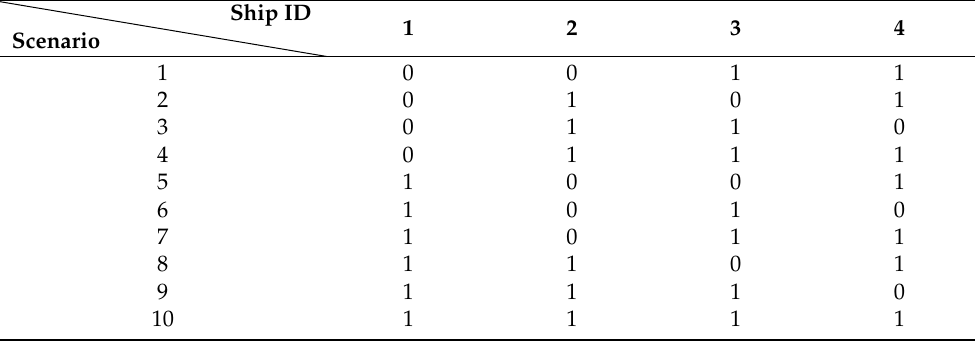
Table 8. Example 2—all possible